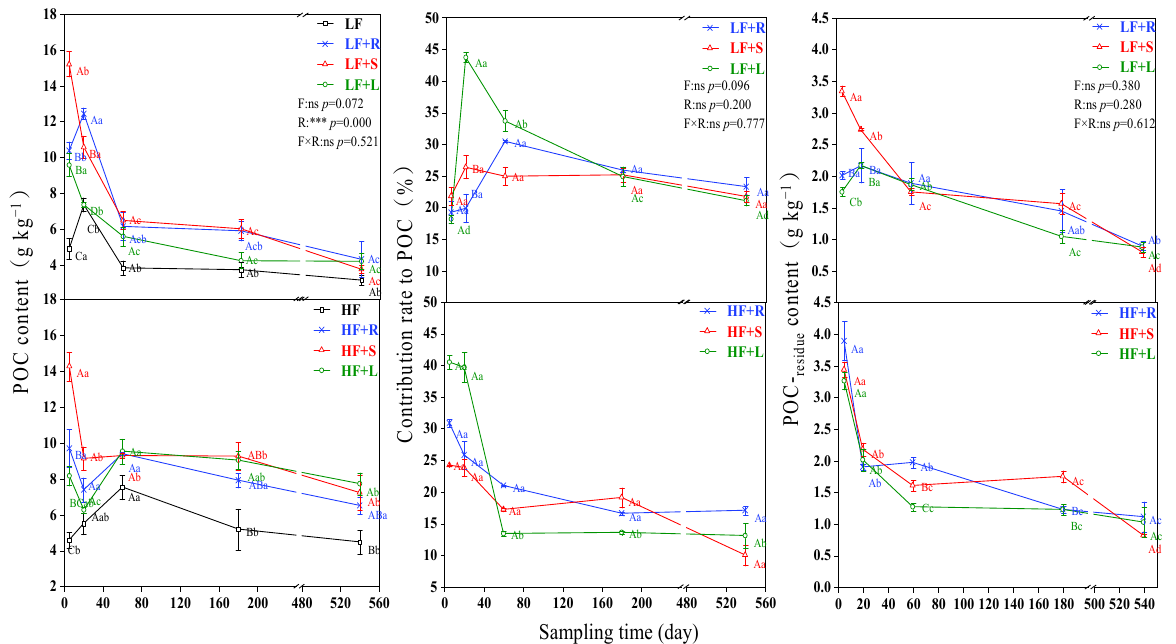
Figure 4. Distribution of different straw residues in POC in different fertility soils over 540 days of the experiment. POC- residue represents the content of carbon derived from different residue types in POC. LF and HF represent low- and high-fertility soil levels, respectively. R in blue, S in red and L in green represent the residues of root, stem and leaf, respectively. Error bars represent the standard deviations from the mean (n = 3). F, R and F × R in black represent fertility level, residue type and the interaction of fertility level and residual type. *** and ns indicate significant difference at p < 0.001, and no significance by ANOVA analysis, respectively. Different uppercase letters indicate significant differences between different treatments in the same sampling time, while different lowercase letters indicate significant differences between different sampling times in the same treatment ( p < 0.05).